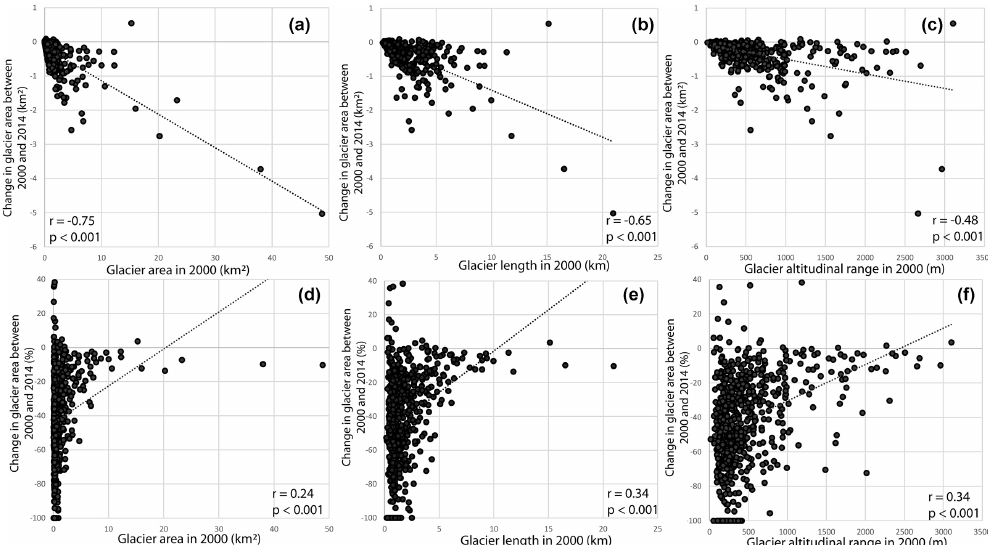
Figure 7. Relationships between glacier area changes from 2000 to 2014 (in km 2 ) and glacier (a) surface area, (b) length and (c) altitudinal range. These same relationships, but with percentage area loss are plotted in (d) , (e) and (f) .